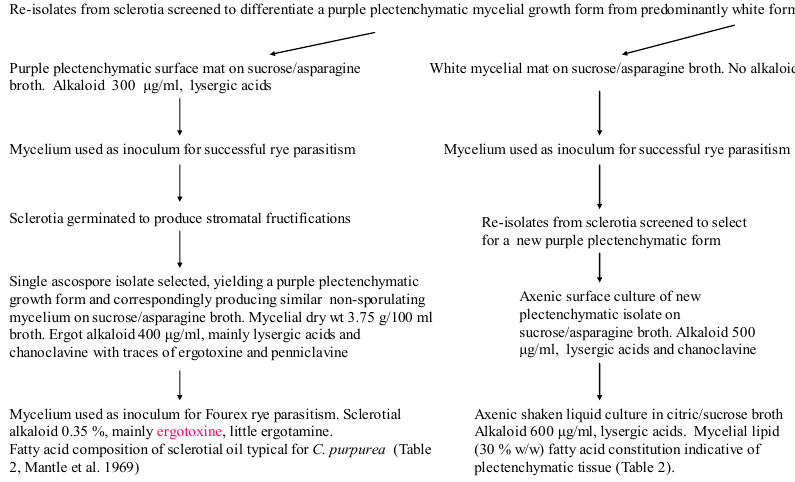
Scheme 3. Sequential states for ergot from Alopecurus myosuroides.